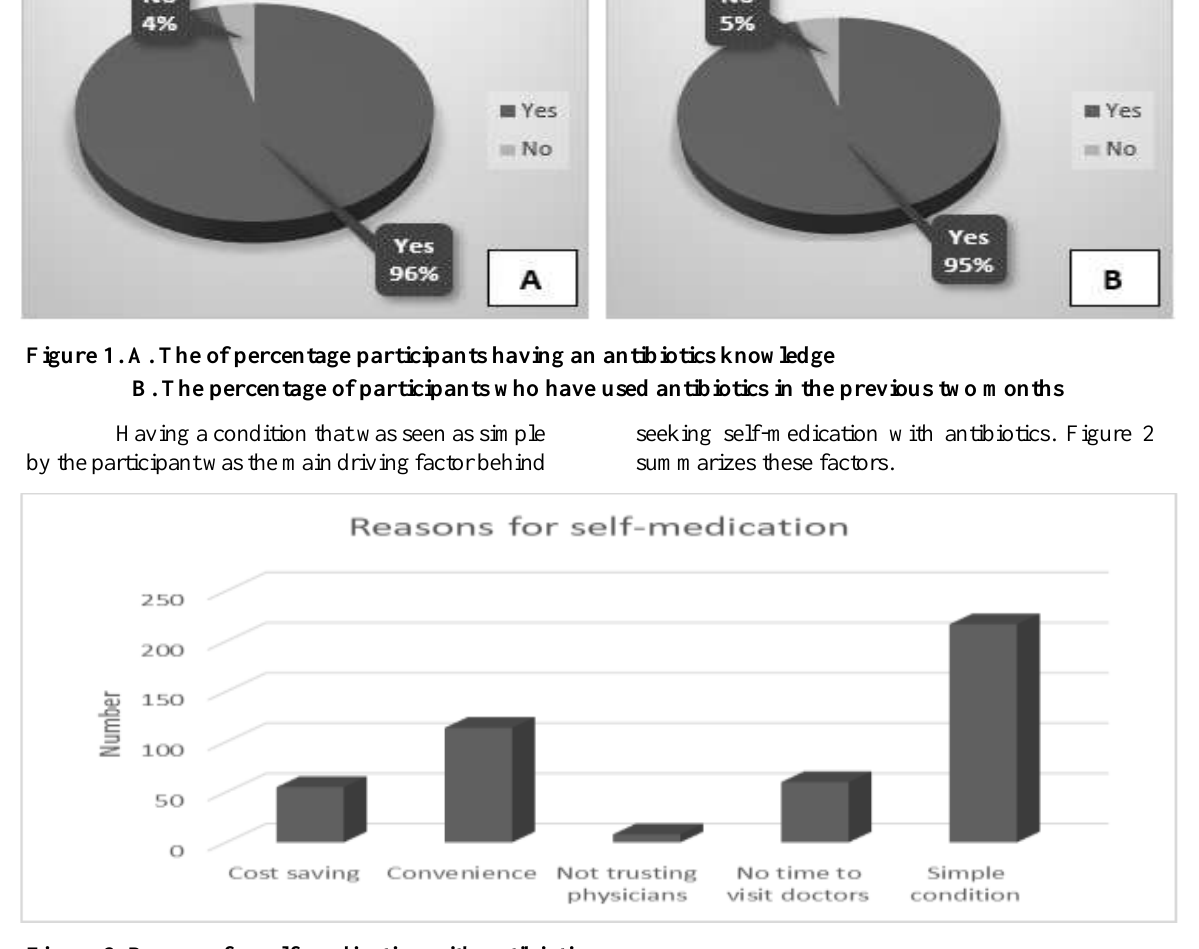
Figure 2. Reasons for self-medication with